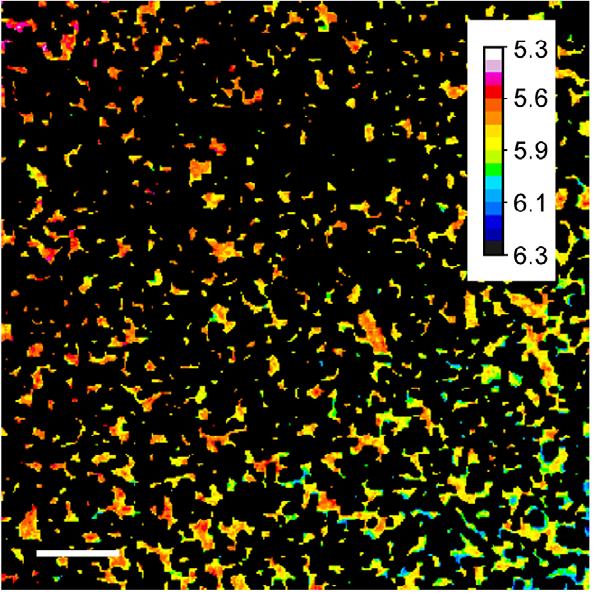
Figure 3. Extracellular pH gradients in the model biofilms. A biofilm was exposed to sterile saliva containing 0.4% (w/v) glucose and the ratiometric pH-sensitive dye C-SNARF-4. Bacterial cells were removed from the image, and extracellular pH was determined. False colours have been used to represent the local pH as shown in the scale bar appended to the image. The higher cell density in the top left part of the picture is correlated with lower pH values, as compared to the bottom right part. Bar=20 m m.